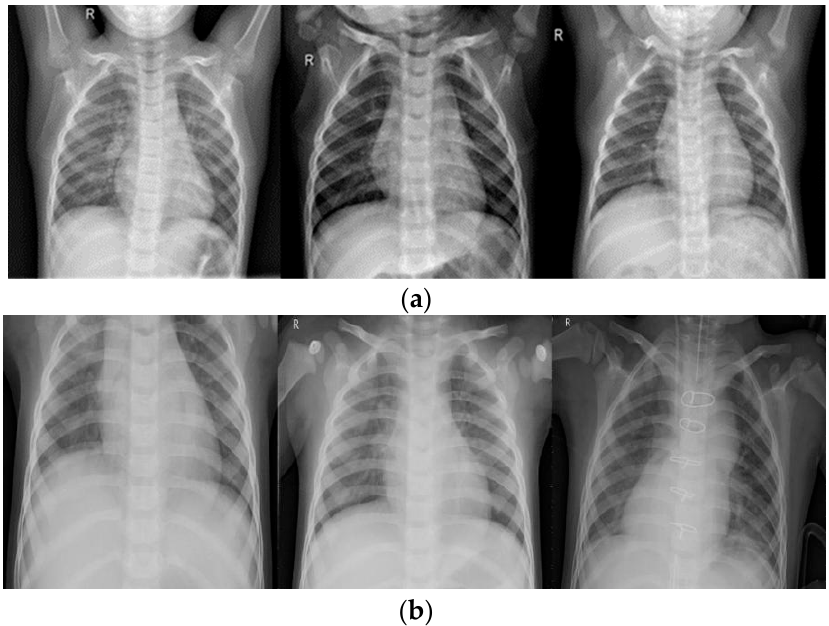
Figure 1. Examples from the dataset. ( a ) normal cases, ( b ) pneumonia cases.